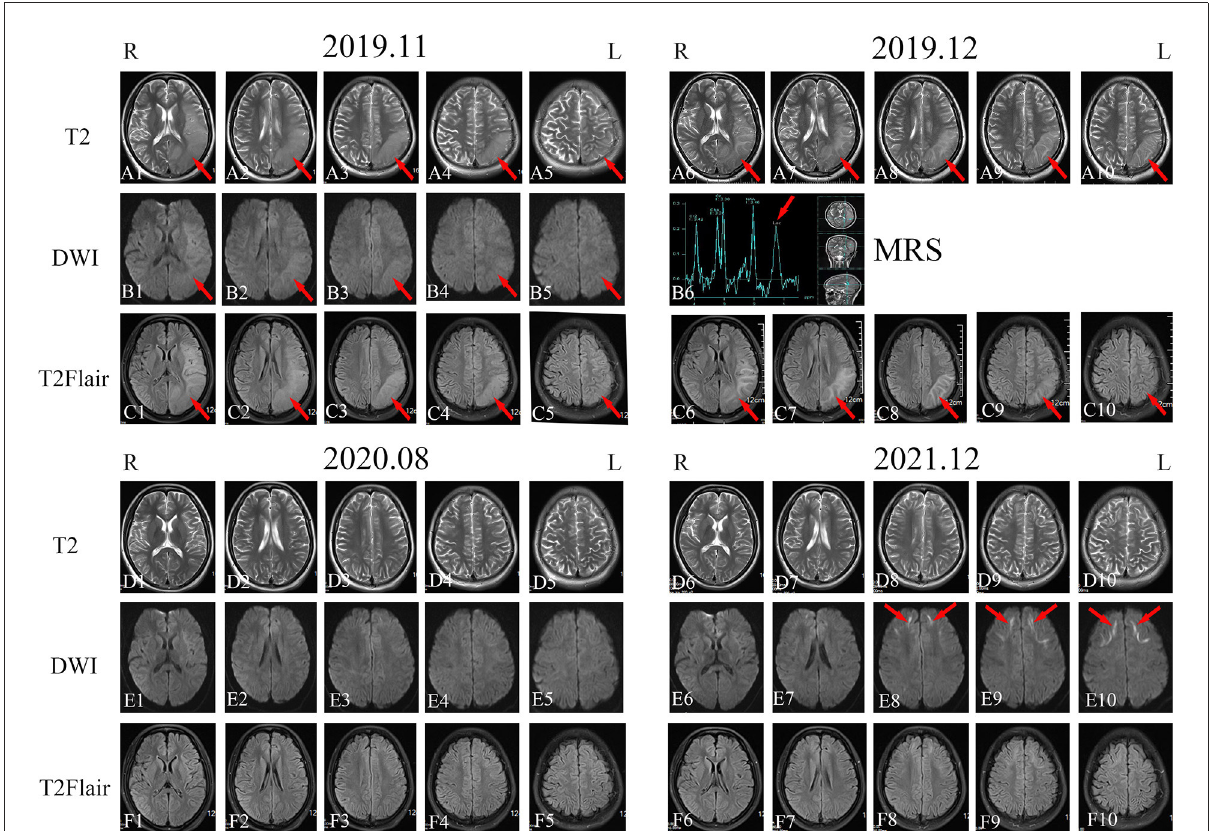
FIGURE1 Imaging examination of patient 1. Head magnetic resonance imaging (MRI) in November 2019 showed high-signal intensity in the left temporal, parietal, and occipital lobes on T2-weighted imaging, diffusion-weighted imaging (DWI), and T2 fluid-attenuated inversion recovery (FLAIR) sequences [ (A1–A5) , (B1–B5) , and (C1–C5) ; red arrows]. MRI in December 2019 showed high-signal intensity in the left temporal, parietal, and occipital lobes on T2-weighted imaging, magnetic resonance spectroscopy, and T2 FLAIR sequences [ (A6–A10) , (B6) , and (C6–C10) ; red arrows]. Head MRI in August 2020 revealed that the high-intensity signal on the left temporal, parietal, and occipital lobes on T2-weighted imaging, DWI, and T2 FLAIR sequences had disappeared [ (D1–D5) , (E1–E5) , and (F1–F5) ]. Head MRI in December 2021 showed bilateral and relatively symmetrical ribbon signs with high-intensity signals along the corticomedullary junction of the frontotemporal-parietal lobes on DWI [ (D6–D10) , (E6–E10) , and (F6–F10) ; red